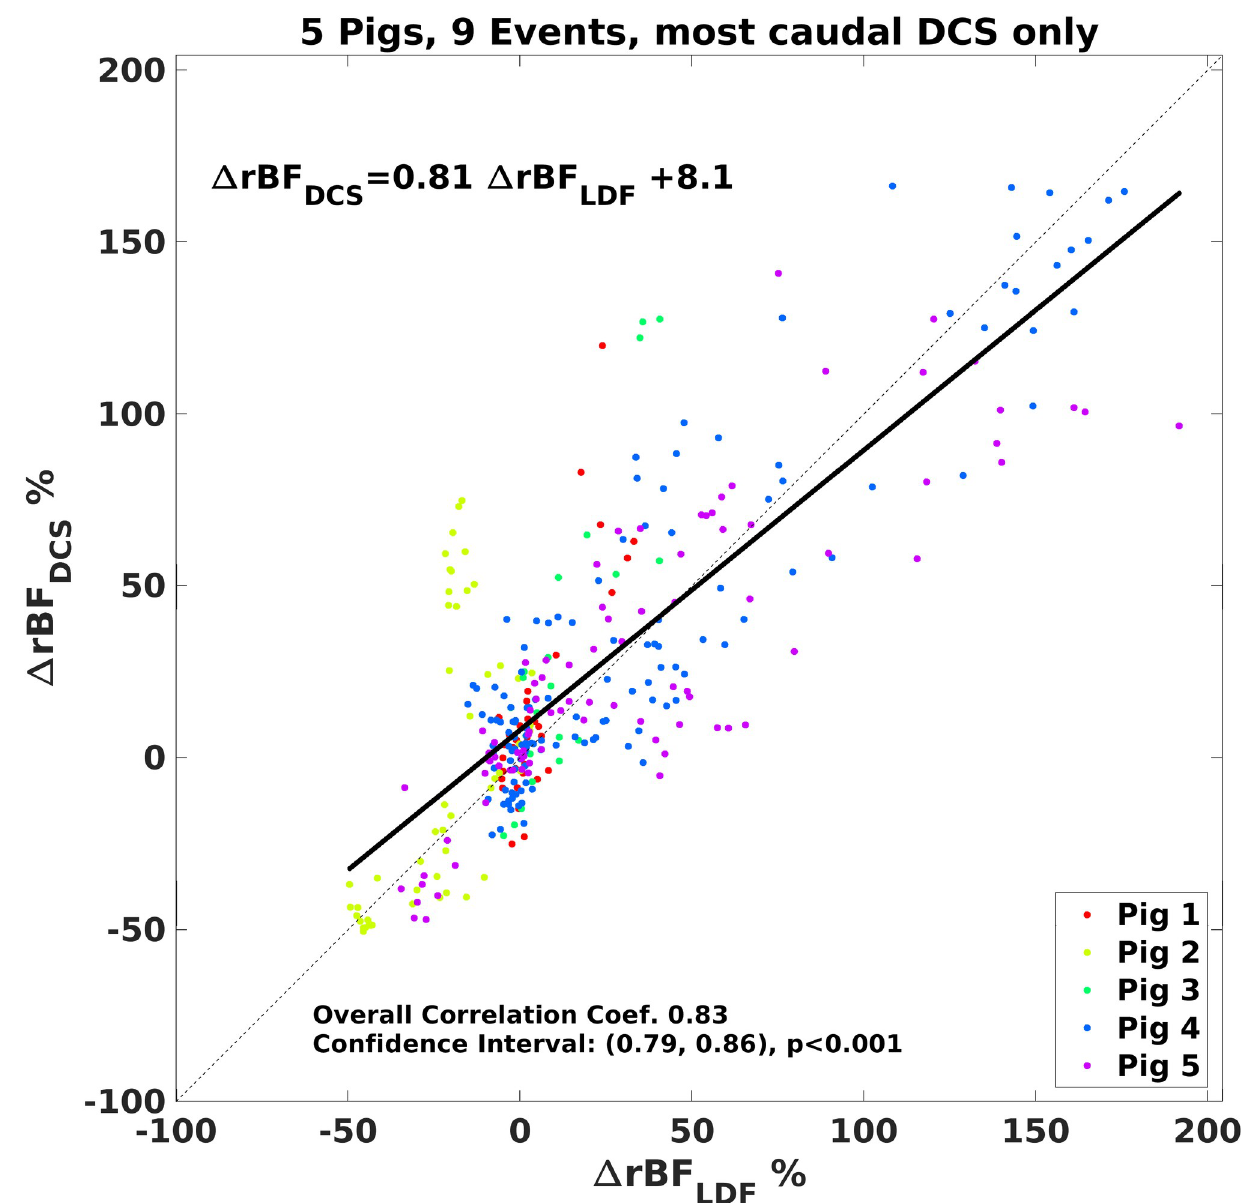
Fig 5. Comparison of changes in relative cerebral blood flow measured by the LDF and most caudal DCS sensors. A best linear fit line is shown (black) along with a 1:1 line (dashed black line). The overall correlation coefficient was 0.83 (p < 0.001; 95% confidence interval, (0.79, 0.86)). Measurements made in 5 pigs during hypoxia-hypercarbia (pCO 2 range 20.7 to 93.7 mmHg). the balloon is positioned cephalad to each sensor level (e.g., red shaded regions in Fig 6), flow decreases. In this example, we observed little or no change in flow in FLOXsp detector regions when the balloon was placed caudal to the sensor position (e.g., blue shaded regions in Fig 6). The more caudal the balloon was to the level of measurement, the less perturbation during bal- loon inflation was observed.